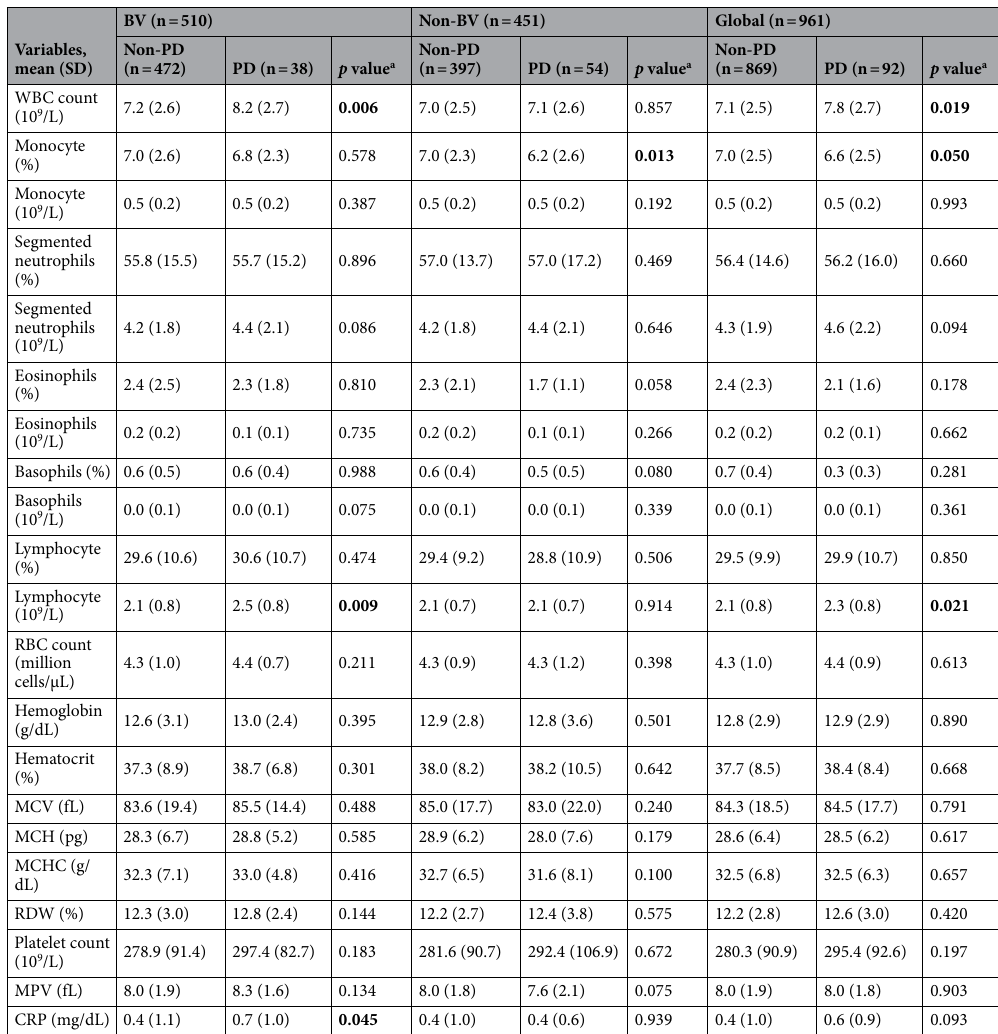
Table 2. Hematologic counts according to bacterial vaginosis and periodontal state. Significant correlations are identified in bold ( p < 0.05). BV, patients with bacterial vaginosis; CRP, C-reactive protein; Non-BV, patients without bacterial vaginosis; P(−), no periodontitis, P(+), periodontitis; WBC, white blood cells; RBC, red blood cells; MCV, mean cell volume; MCH, mean cell hemoglobin; MCHC, mean cell hemoglobin concentration; RCD, red cell distribution; MPV, mean platelet volume. a Mann–Whitney test for continuous variables, p <